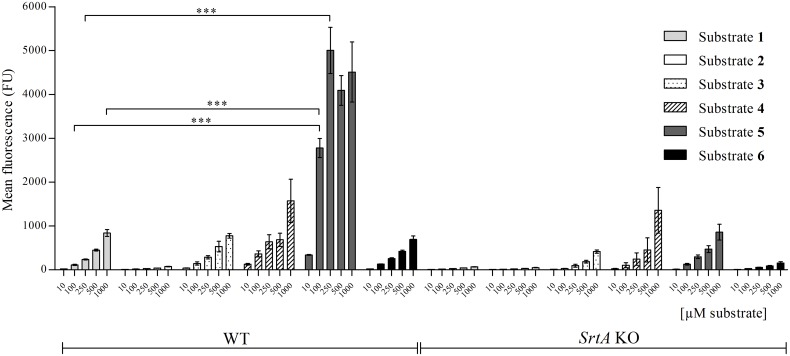
Titrations of the SrtA synthetic substrates.Cultures of 8325–4 WT and srtA KO strains were incubated in LB medium during 24 hrs in the presence of either substrate 1; 2; 3; 4; 5 or 6 [13] at 10 μM, 100 μM, 250 μM, 500 μM or 1 mM and analysed by FACS. The synthetic substrate concentrations used are depicted on the X-axis and the mean fluorescence, as a measure for the level of substrate incorporation into the bacterial cell wall, was plotted on the Y-axis. Substrate 1 signal at 100 μM and 250 μM was significantly lower than the signals obtained with substrate 5 at the same concentration (P < 0.0001). Substrate 1 signal obtained at 1 mM was significantly lower than the signal obtained with substrate 5 at 100 μM (P < 0.0001). Only the most relevant significant differences are presented.